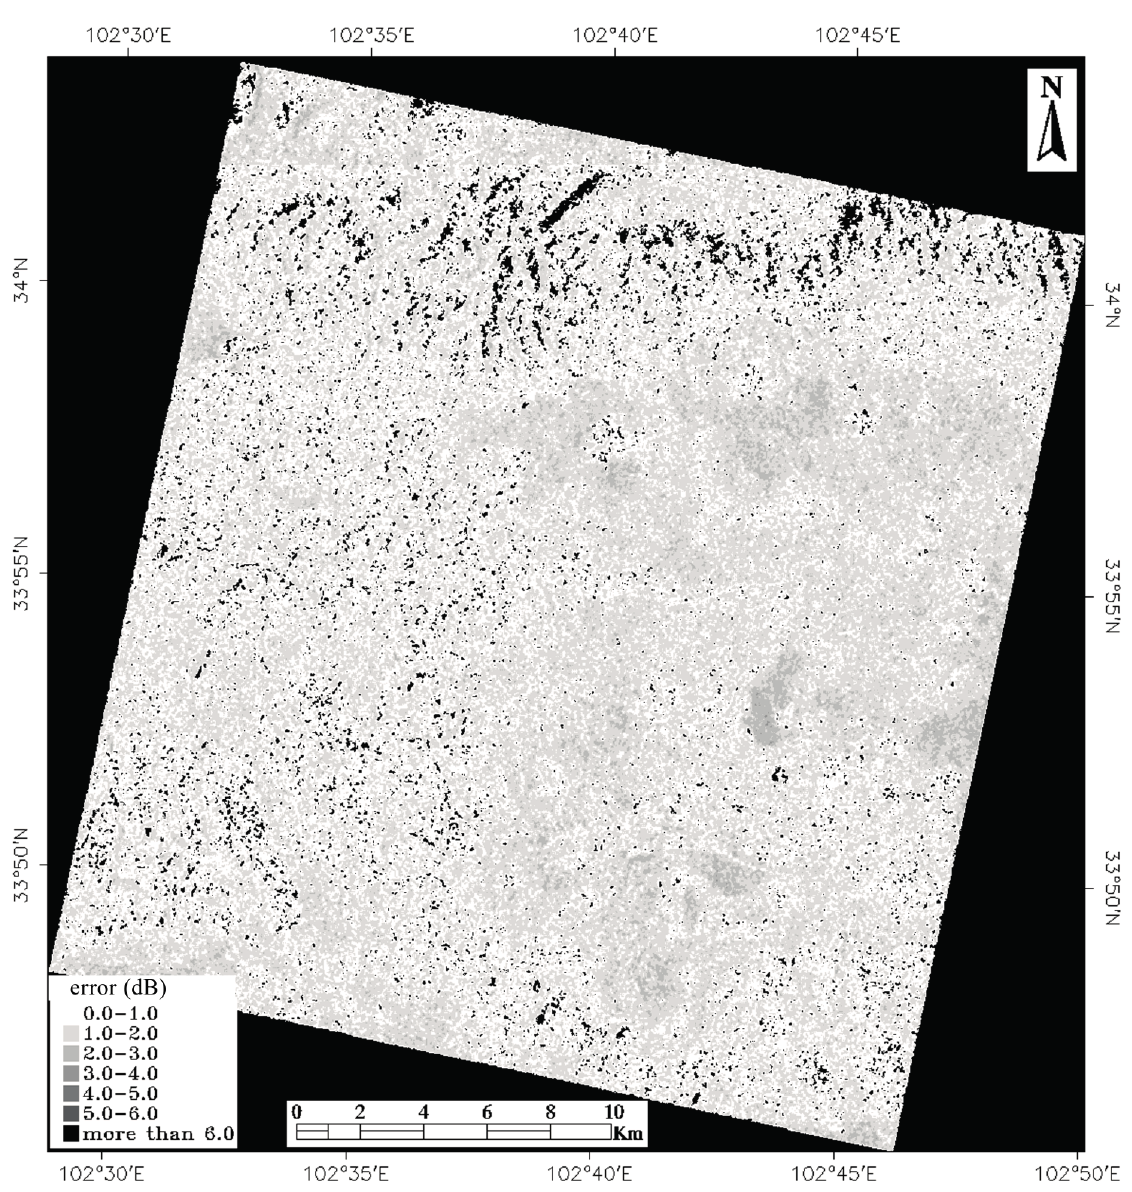
Figure 4. The absolute error map of the model